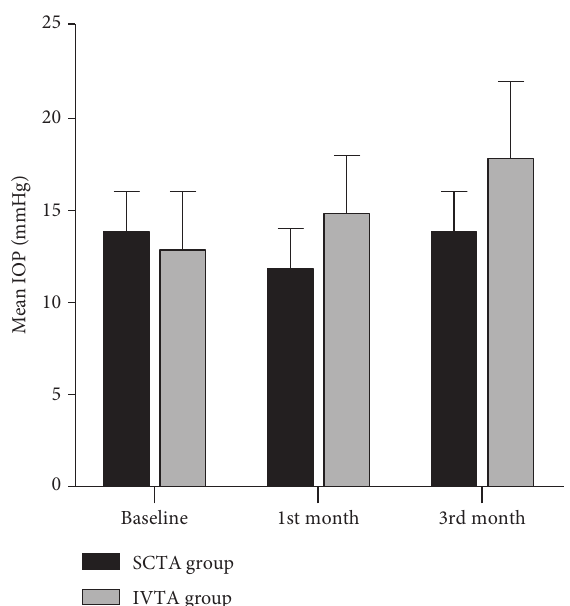
Figure 4: IOP in both groups at baseline, one month, and three